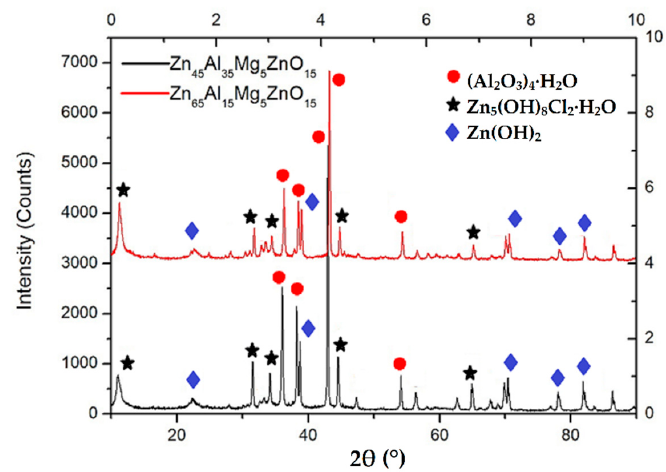
Figure 10. XRD analysis of the corrosion products of Zn 65 Al 15 Mg 5 ZnO 15 and Zn 45 Al 35 Mg 5 ZnO 15